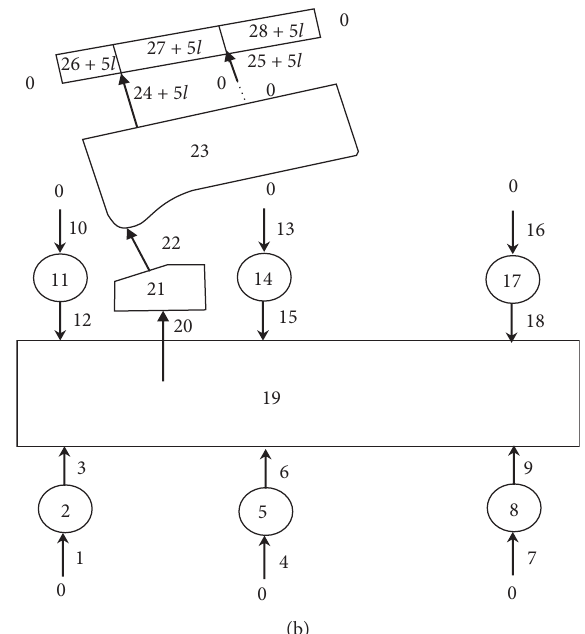
Figure 4: The model of the MLRS: (a) the dynamic model; (b) the